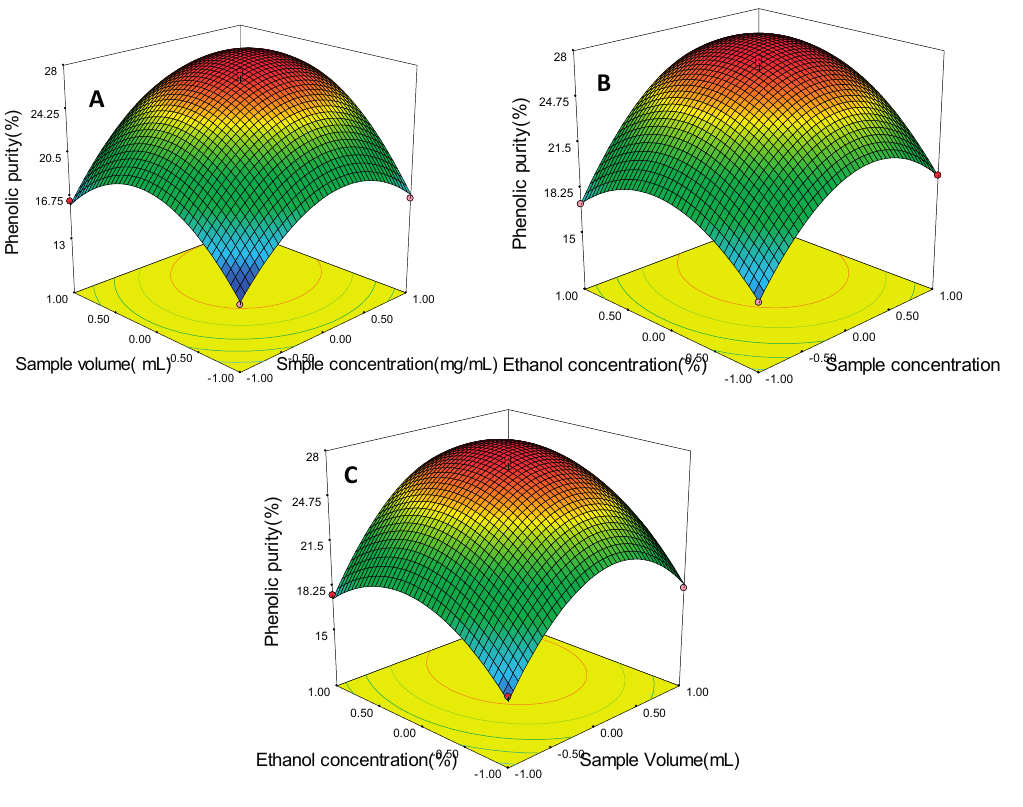
Figure 2. Response surface plots showing the effect of sample phenolic concentration (mg/mL), sample volume (mL) and ethanol concentration (%) on the phenolic purity (%). ( A ) the effect of sample phenolic concentration (X1) and sample volume (X2); ( B ) the effect of sample phenolic concentration (X1) and ethanol concentration (X3); ( C ) the effect of sample volume (X2) and ethanol concentration